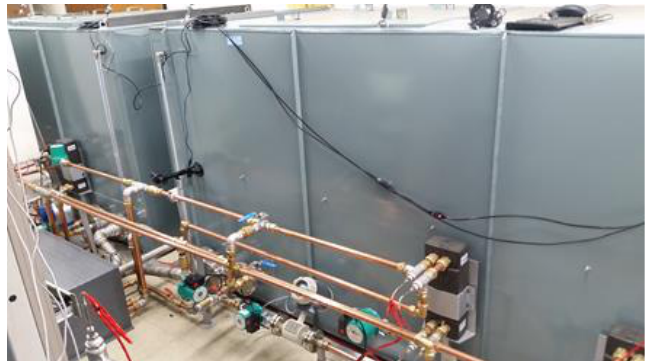
Figure 2. The facility of the lab-scale bio-hydrogen production system setup.